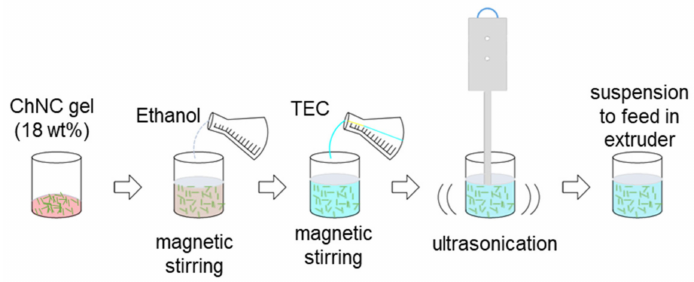
Figure 8. Schematic of the ChNC suspension preparation for liquid feeding.